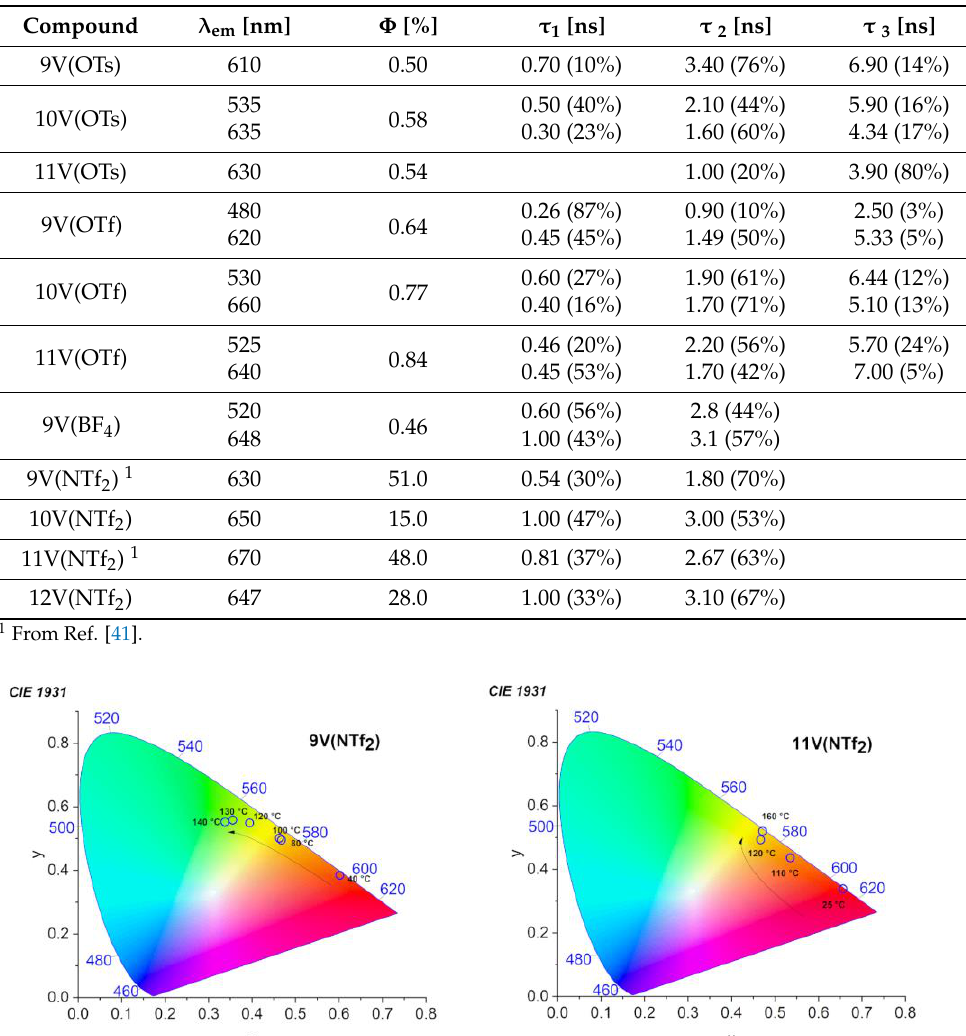
Figure 3. Temperature dependent 1931 CIE chromaticity coordinates of the fluorescent emission of 9V(NTf 2 ), 9V(BF 4 ), 9V(OTf), 10V(NTf 2 ), 11V(NTf 2 ), 11V(OTs).